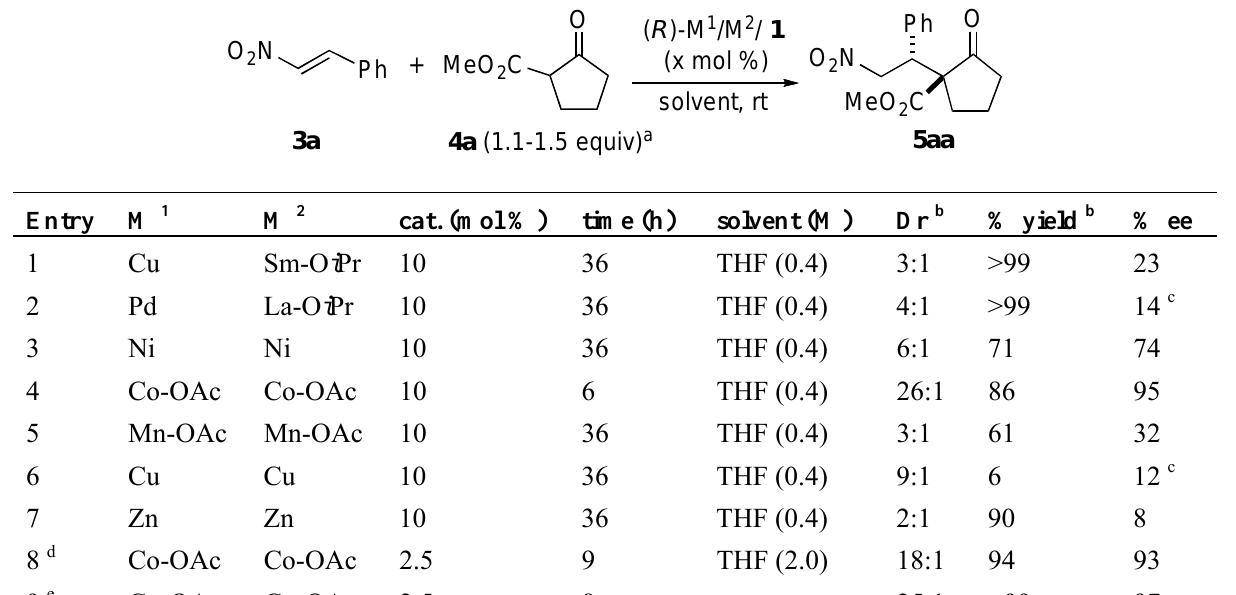
Table 1. Screening of bimetallic M 1 / M 2 /Schiff base complexes for 1,4-addition of β -keto ester 4a to nitroalkene 3a